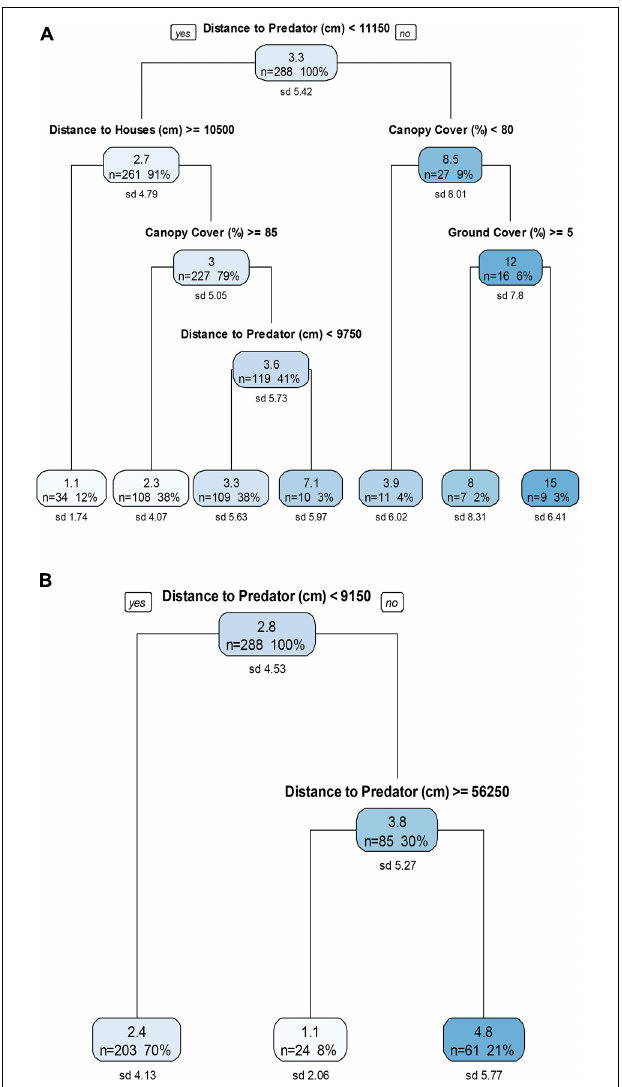
FIGURE 3 | Descriptive regression decision trees for four sessions of three nights each of (A) pre-treatment and (B) treatment giving-up density (GUD) trials at the close environment, an urban-edge disturbed forest green space. The top number in each node is the GUD, the mean number of mealworms left in the tray (after ∼ 12 h nocturnal exposure). The number of GUD station surveys included in the data split at each node is given by the “ n ” number. The “%” value is its corresponding percentage from the full data set ( n = 288). The standard deviation of the mean number of mealworms left at each node is given by the “sd” value. The six treatments in (B) included: control, domestic cat cue, red fox cue, human disturbance cue (sound and light), and combined human disturbance and cat or fox